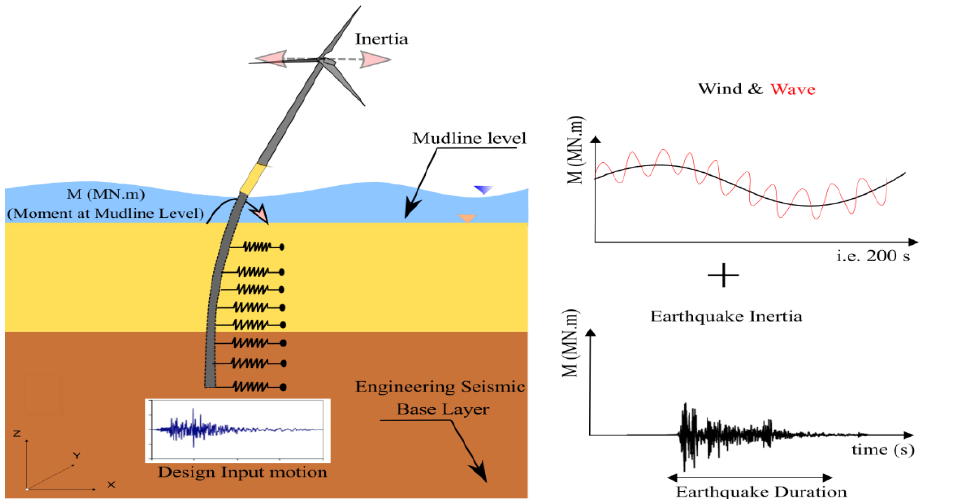
Figure 13. Load combination (wind + wave + earthquake) for a typical offshore wind turbine sited in a seismic prone region.